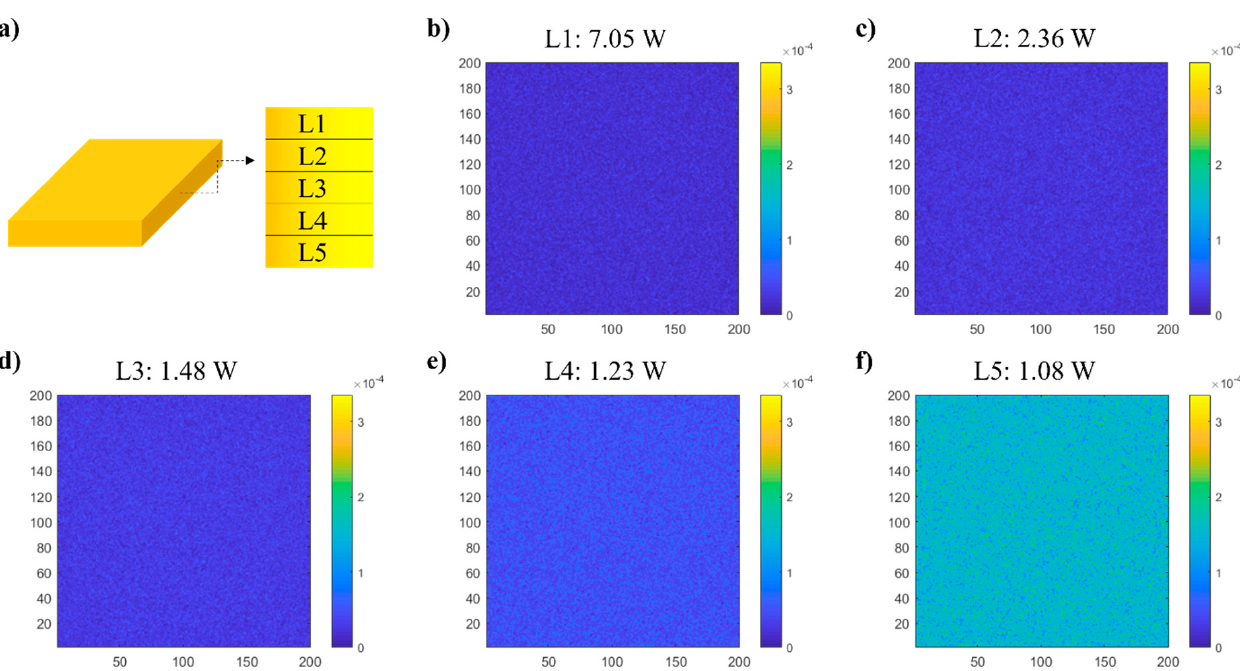
Figure 3. ( a ) Layer configuration of the LSC, and ( b – f ) heat maps of the layers (color bars with the unit of W).